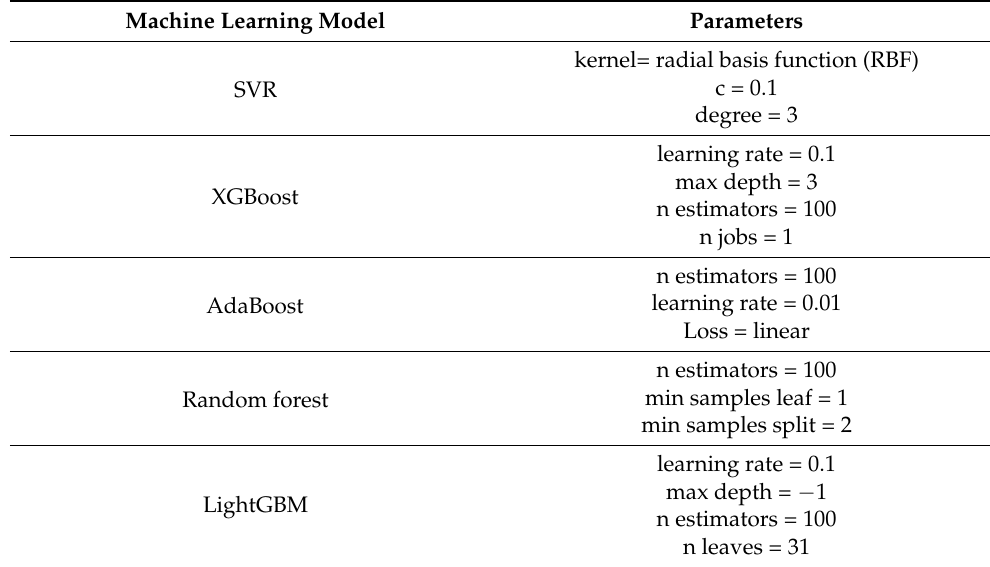
Table 4. Model Architecture for Machine Learning